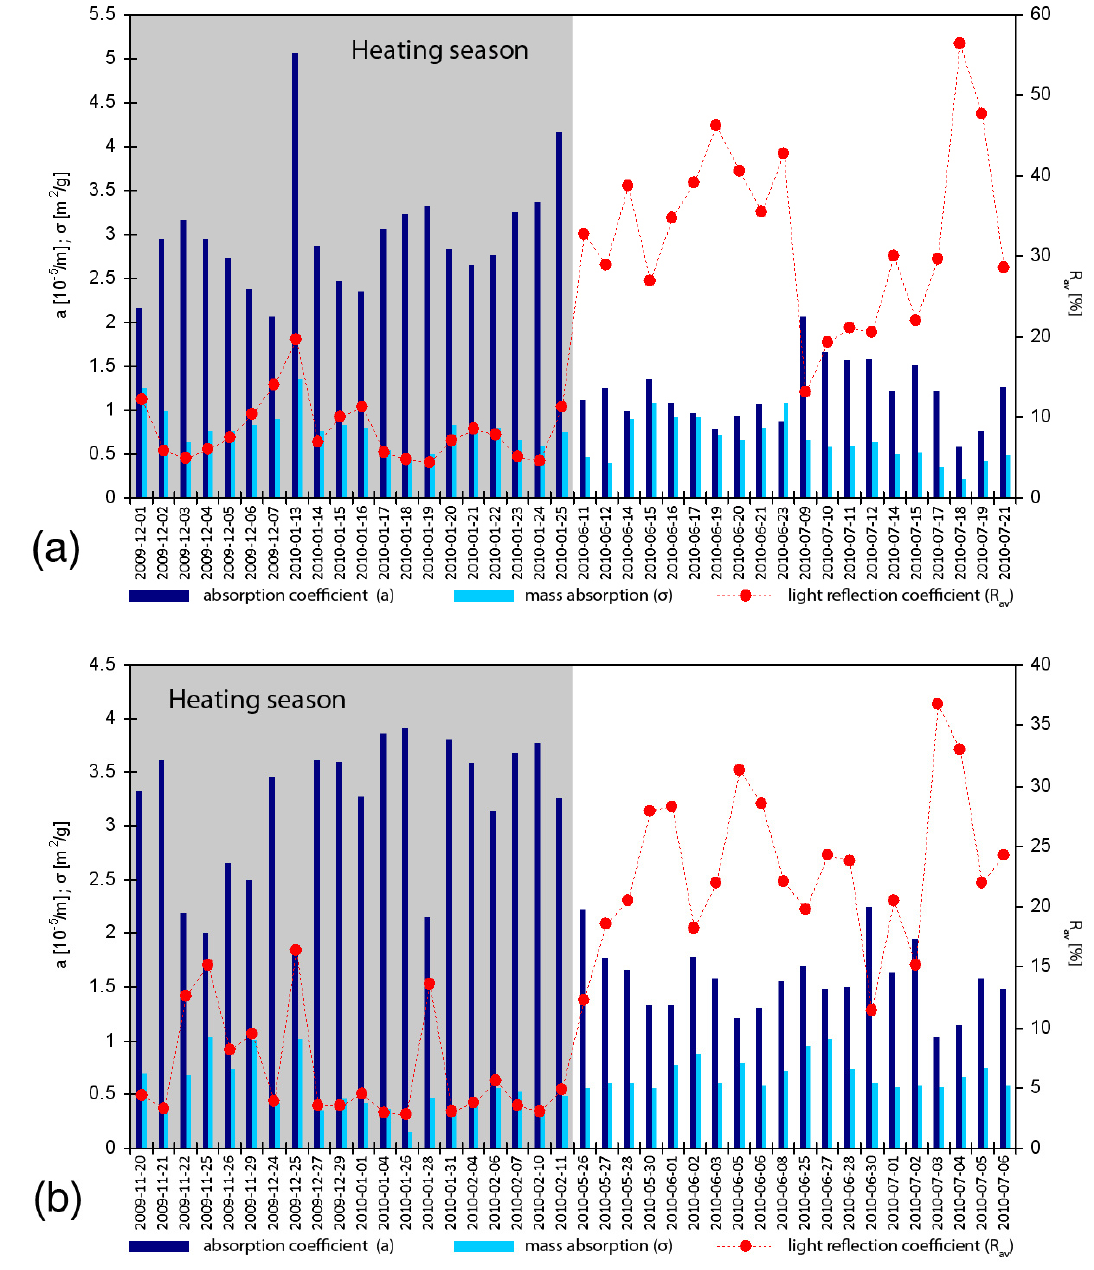
Figure 5. Optical parameters of PM 1 ( a ) and PM 2.5 ( b ) at UB (urban background